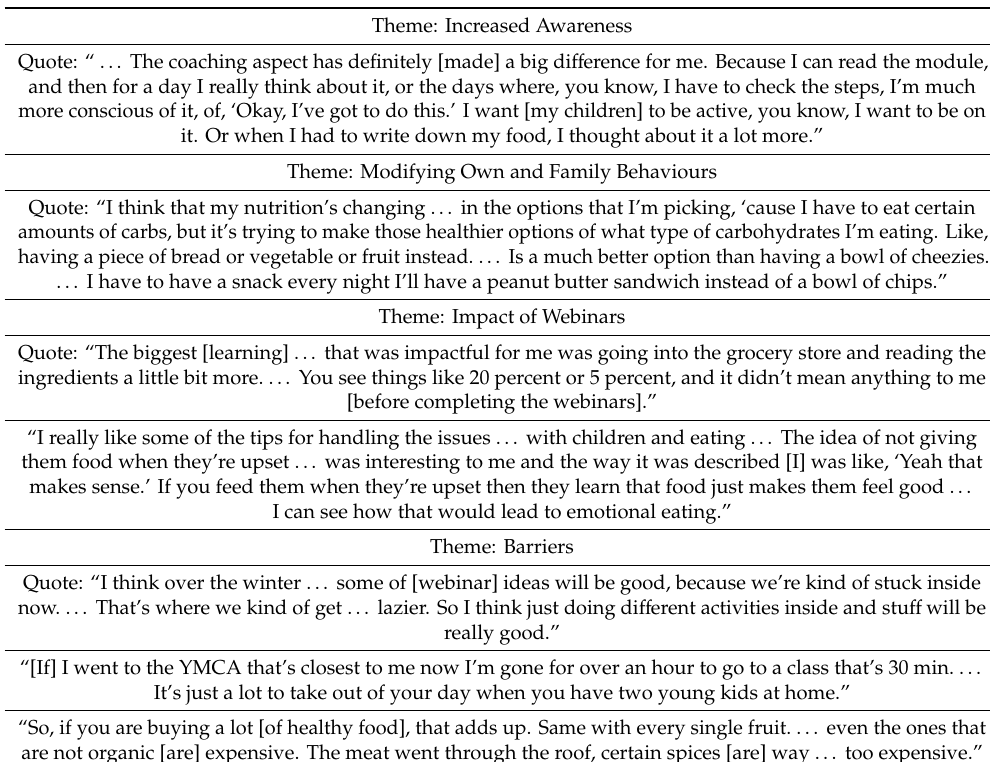
Table 7. Corroborative Quotations for Mid-Intervention Themes and Sub-Themes (Intervention